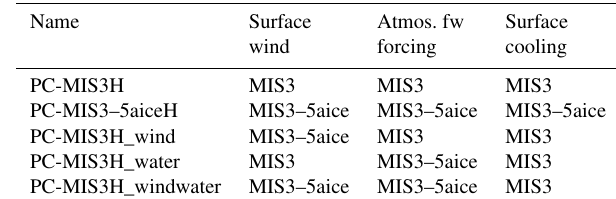
Table 2. List of partially coupled experiments. In each of these ex- periments, atmospheric forcing was replaced by the monthly clima- tologies of the specified